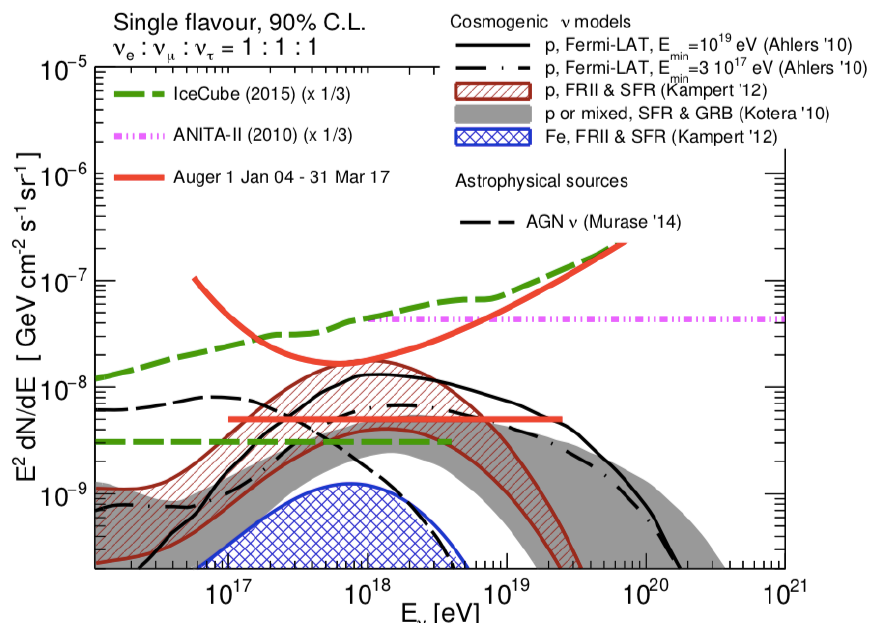
Figure 8: 90% C.L. integral upper limits for a diffuse ultra-high energy neutrino flux dN / dE ν = kE − 2 (horizontal lines represent the normalization k ) and differential upper limits (non-horizontal curves) for the Pierre Auger Observatory (red), ANITA- II (pink) and IceCube (green). Limits are quoted for a single flavor assuming equal flavor ratios. In addition, predictions for several neutrino models are shown. Plot source: [ 14 ]